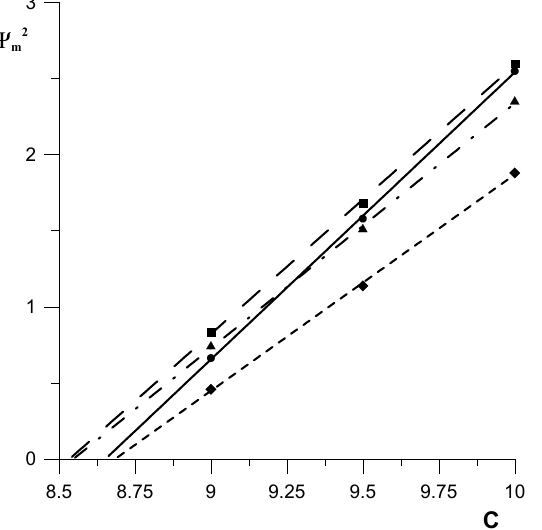
Figure 7. The dependences of stationary flow intensity on the parameter C for various values of k : (cid:4) — k = 1.0, (cid:78) — k = 1.2, — k = 0.8, (cid:7) — k =